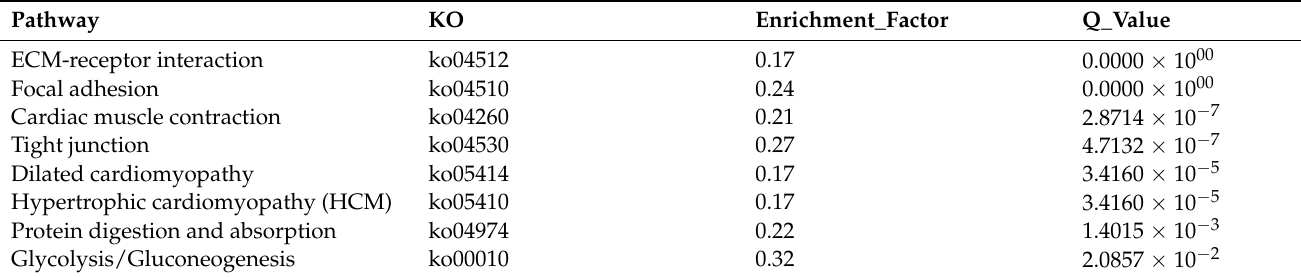
Figure 6. KEGG function classification of differentially expressed genes in YL and GY skin color of A. davidianus . The ordinate is the name of KEGG metabolic pathway, and the horizontal coordinate is the number of genes annotated to the pathway and their proportion to the total number of annotated genes. Table 2. KEGG enrichment of differentially expressed